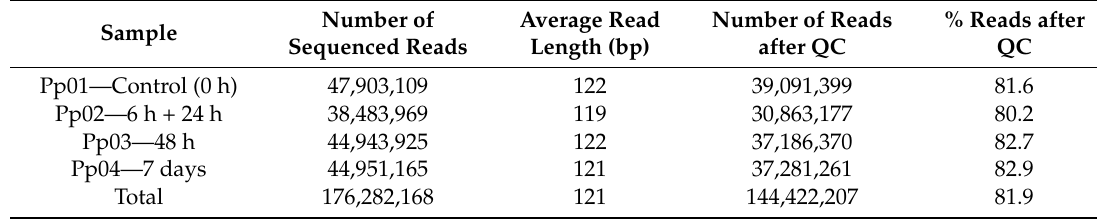
Table 1. Pre-processing statistics for each